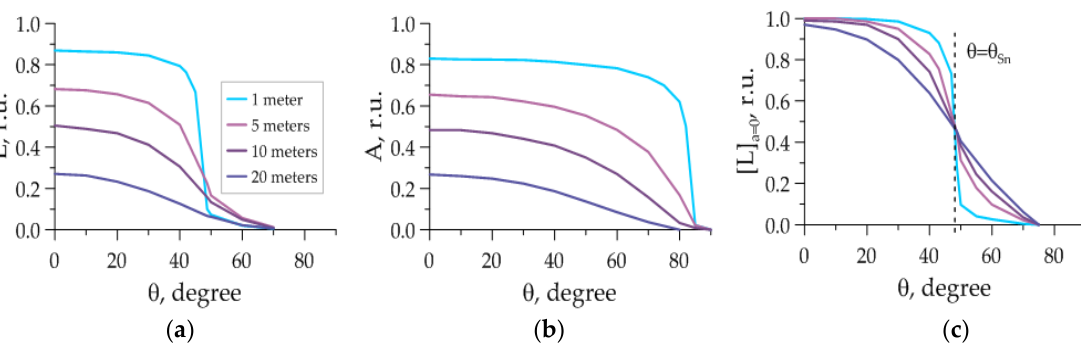
L from Equation (6) for different depths Figure 3. The structure of functions ( a ) L ; ( b ) A ; ( c ) [ L ] from Equation (6) for different depths 0 a = a = 0